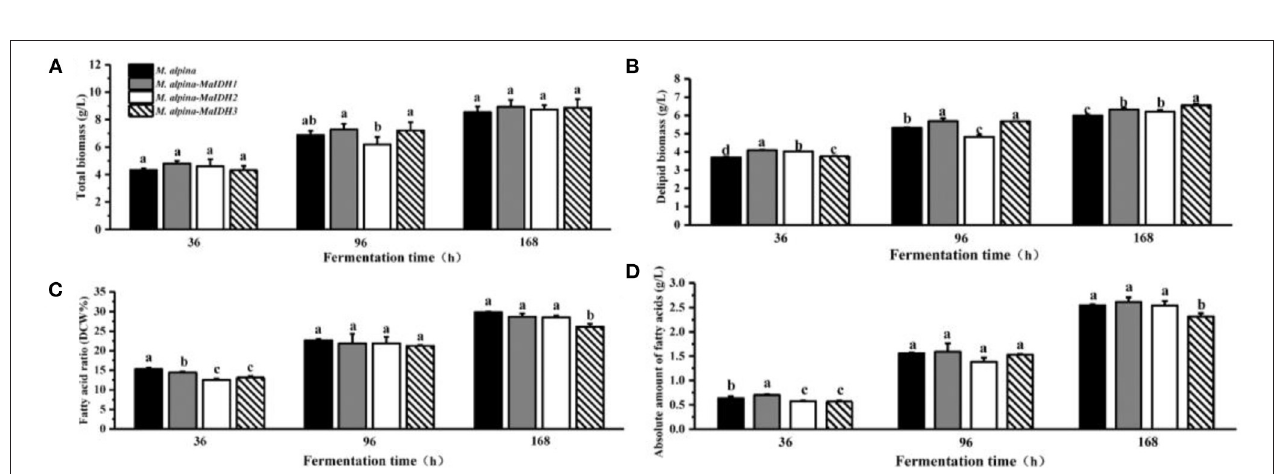
FIGURE 6 | Biomass and lipid accumulation of recombinant strains overexpressing NAD + -MaIDH at different time points (36, 96, and 168h). Different letters indicate significant differences, p < 0.05. (A) Total biomass, (B) delipid biomass, (C) fatty acid ratio, and (D) absolute amount of fatty acids.